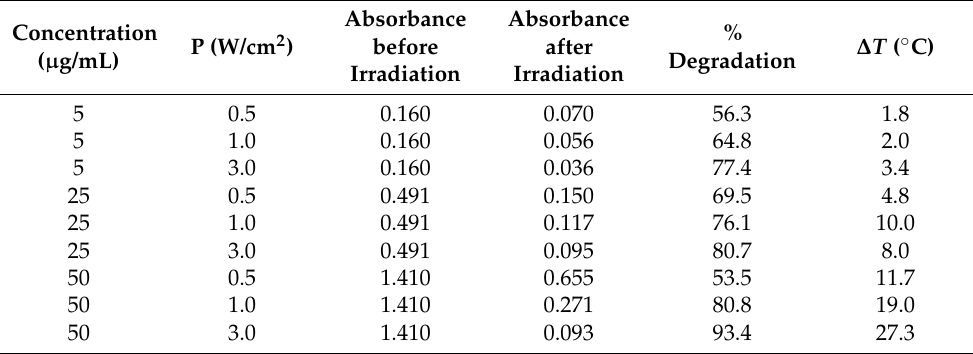
Table 2. Calculated absorbance decrease after irradiation with 808 nm laser (P = 0.5, 1, and 3 W/cm 2 ) of IR-820 solutions in PBS. An increase in temperature ( Δ T ) was calculated by subtracting the initial temperature ( t = 0 s) from the maximum temperature reached.